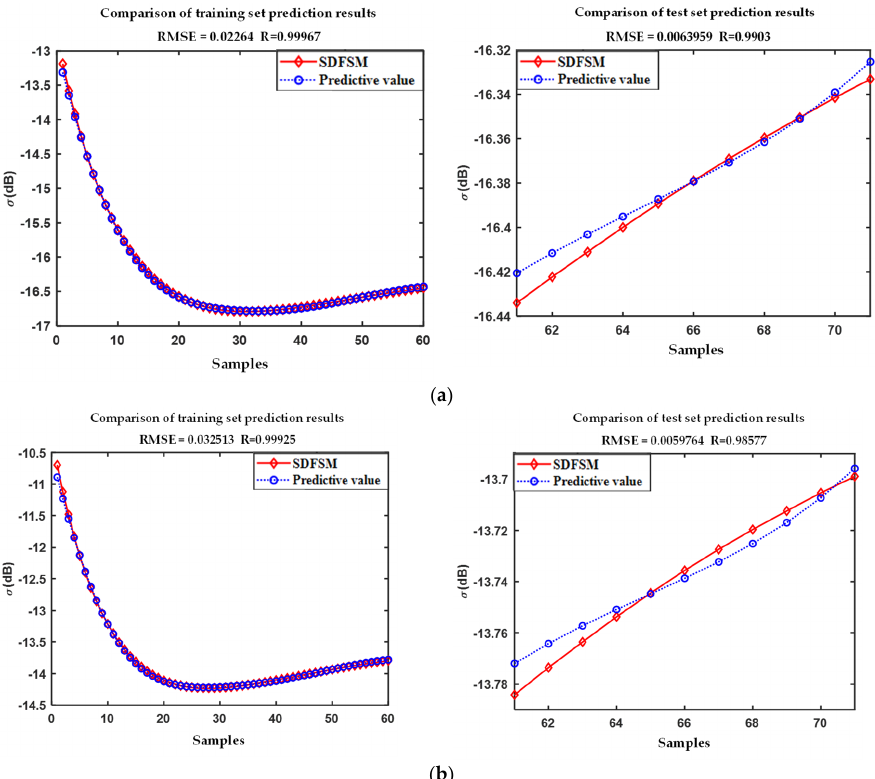
Figure 10. Comparison of the extrapolated prediction results of the IPSO - SVR - based prediction model and the simulation results of SDFSM. ( a ) HH polarization. ( b ) VV